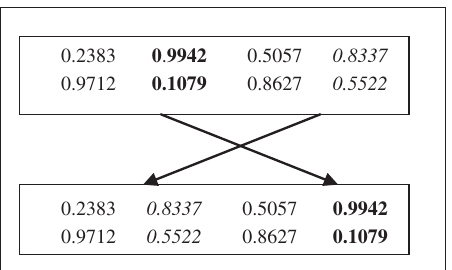
Figure 9. Mutation Operators: Single Qubit